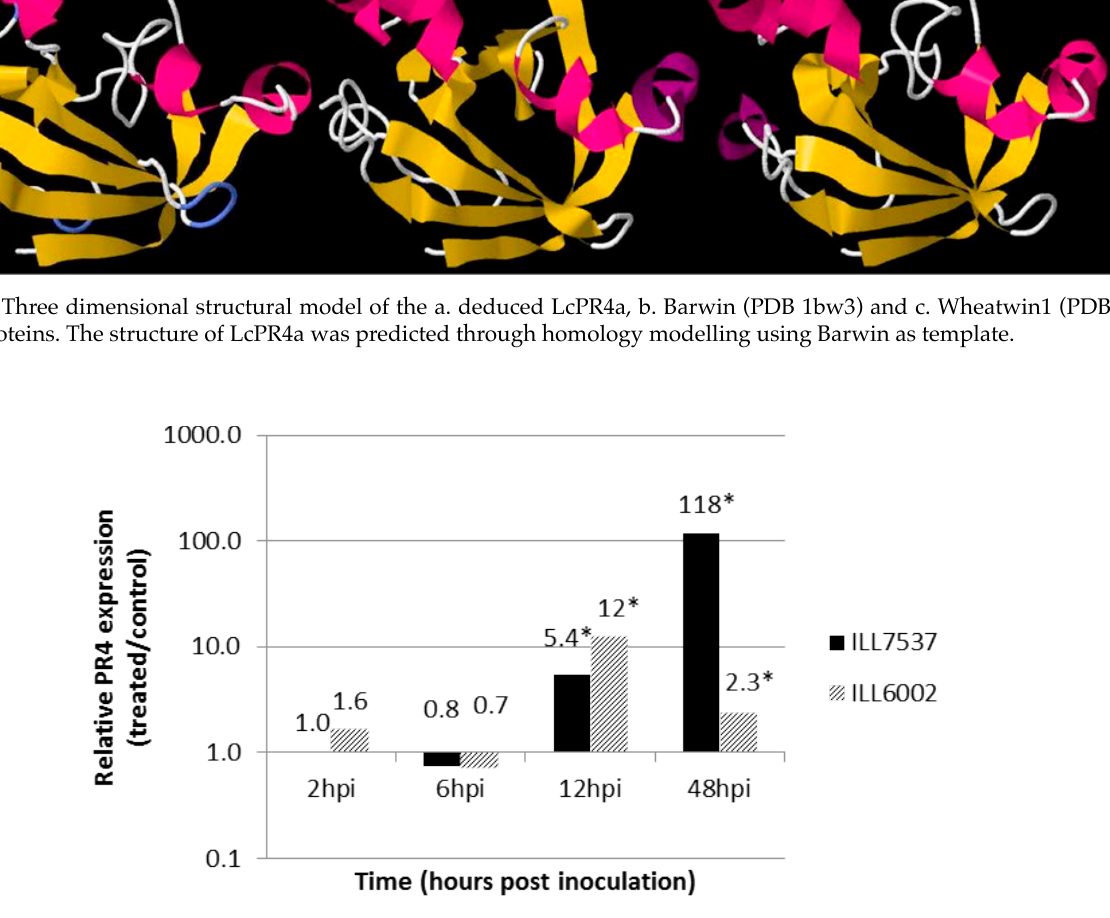
Figure 5. Fold changes in relative transcript level of PR4 gene in the resistant (ILL7537) and susceptible (ILL6002) lentil genotypes. Columns represent average data from four independent samples at each time point. The numbers on each bar show the fold change in PR4 transcript level caused by A. lentis inoculation relative to those in untreated controls at the same time point. The asterisk indicates that the observed fold change was significantly different from the control samples (based on the Wilcoxon two-group